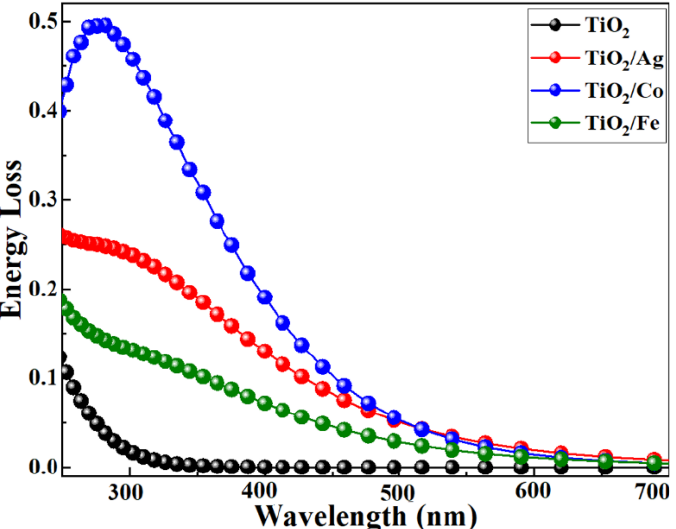
Figure 9. Energy loss vs. wavelength for pristine and transition-metal-doped TiO 2.